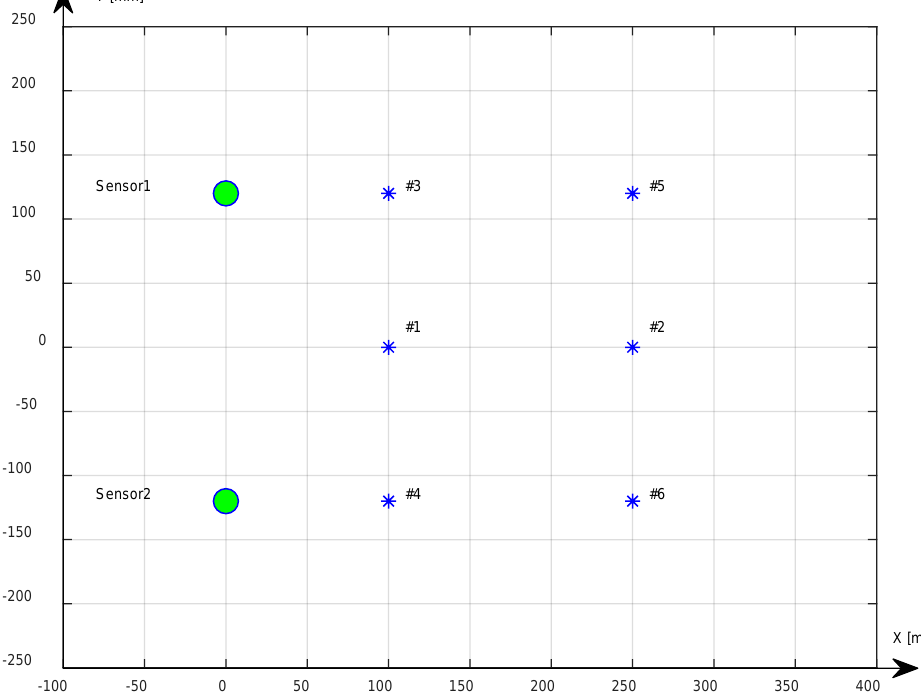
Figure 1. Impact points positions #1, #2, #3, #4, #5, #6 on the aluminum plate. Positions #1, #2 are symmetric respect to Sensor1 and Sensor2.